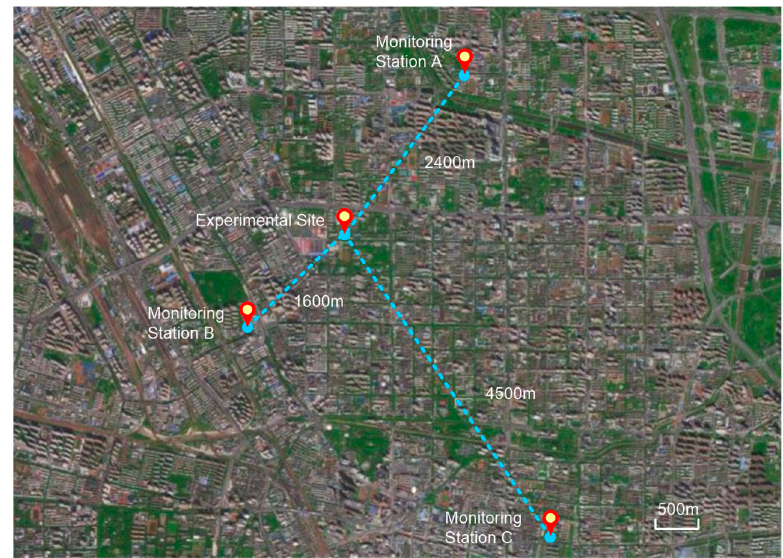
Figure 11. Locations of the experimental site for flight measurement. Monitoring stations A, B, and C are the three national monitoring stations closest to the site in different directions.